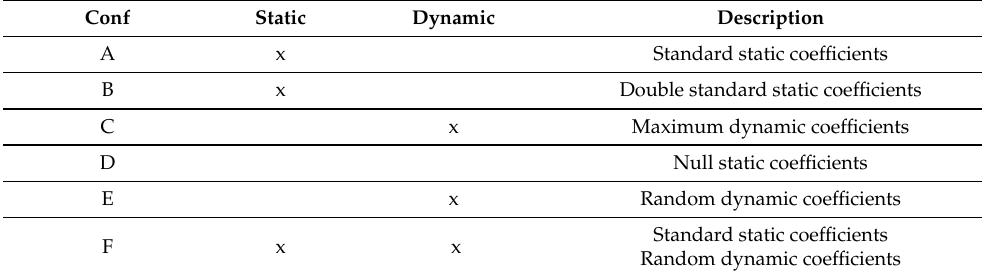
Table 1. Model validation: set of